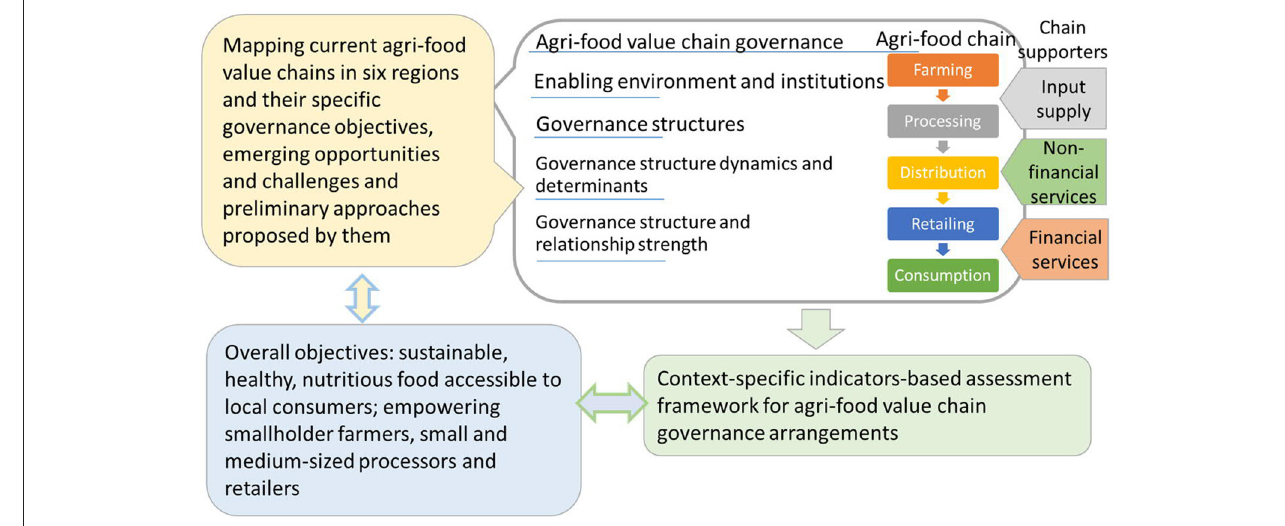
FIGURE 7 | Overview of the structure of the assessment